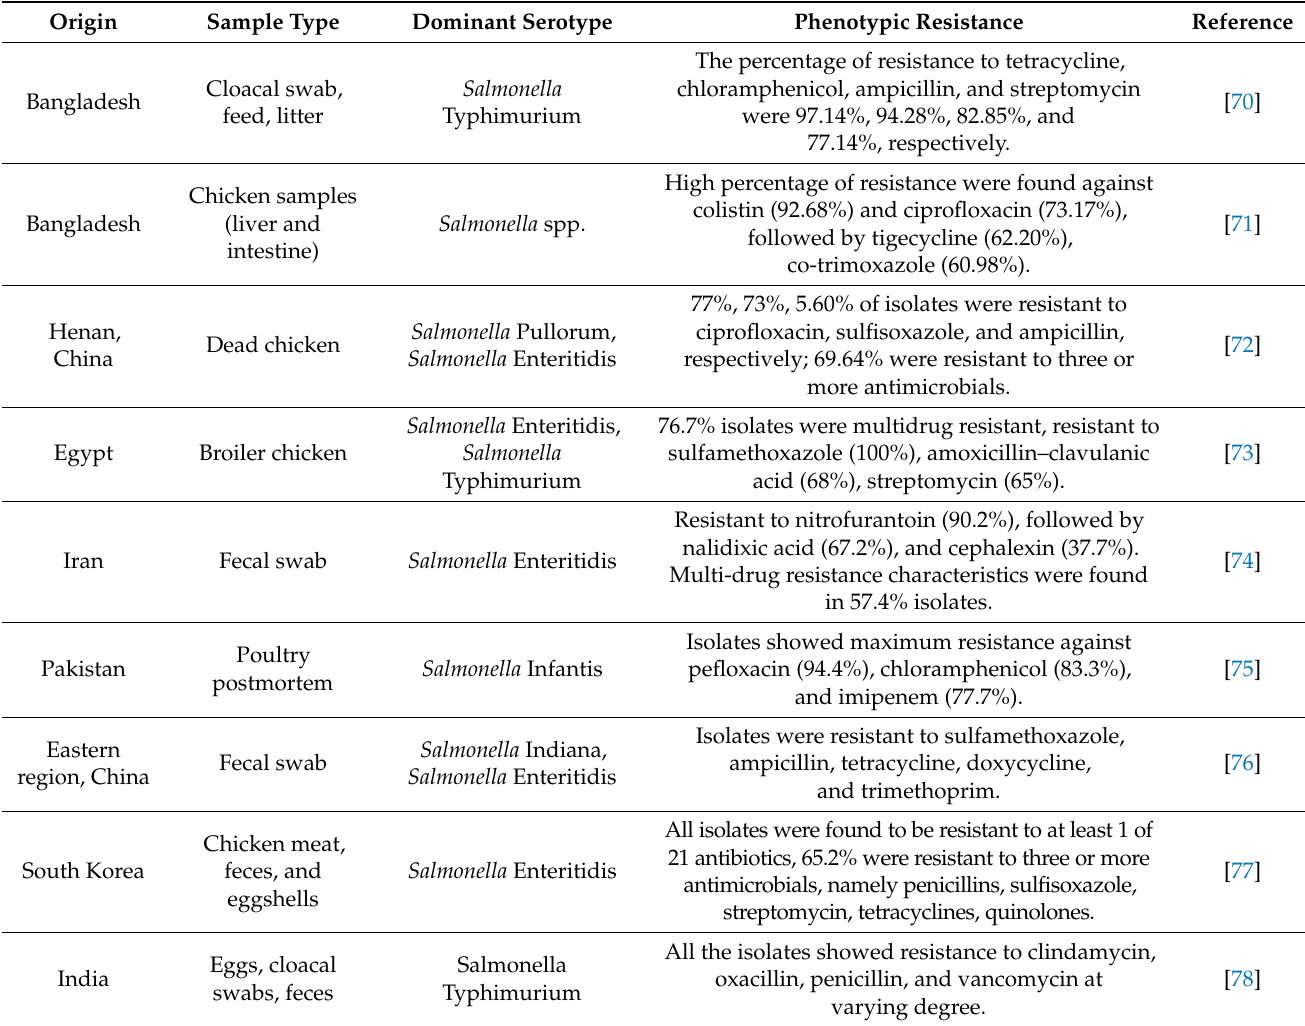
Table 2. Summary of the results of studies on antibiotic resistance among Salmonella isolates in poultry and poultry products in the last